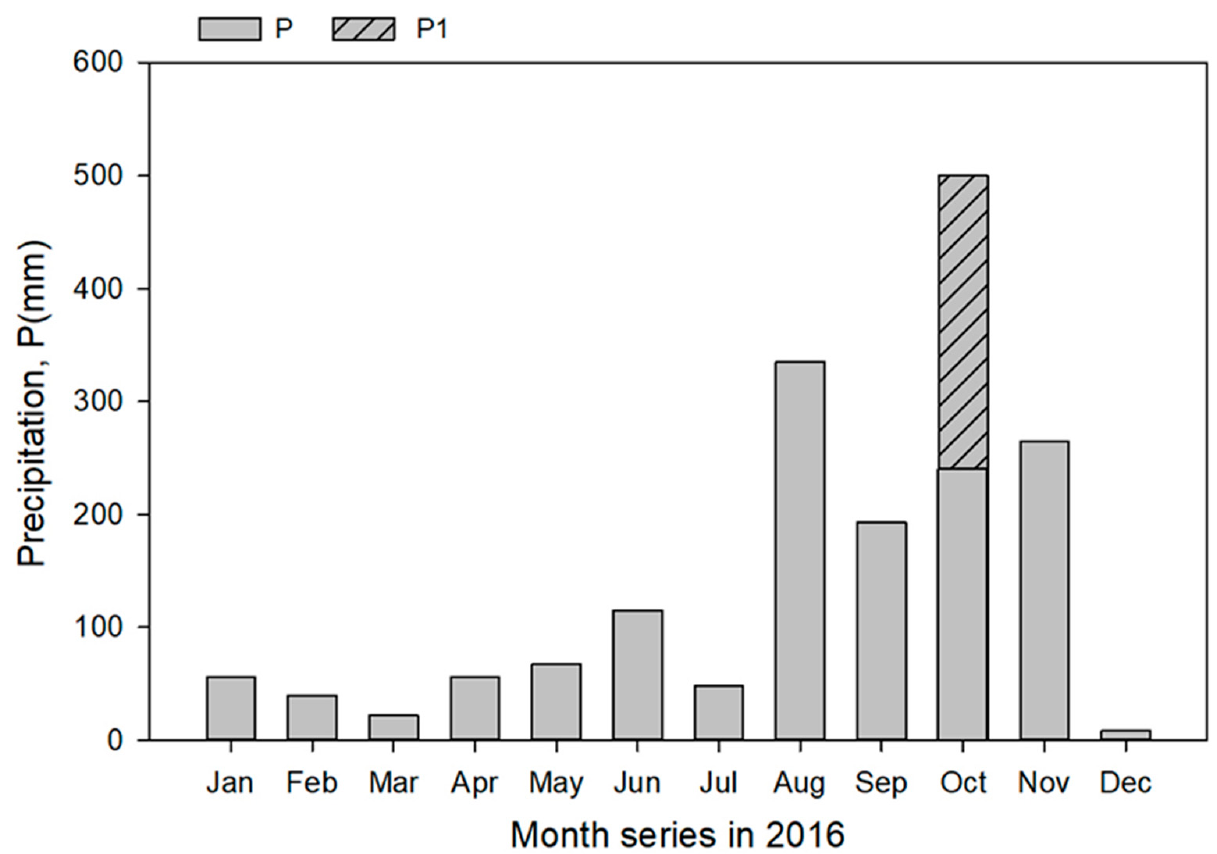
Figure 4. Monthly Dynamic Variation of Precipitation. The actual rainfall in October is P + P1, where P is the measurement data of the study area, and P1 is the data missing due to instrument failure during typhoon “Sarija”.